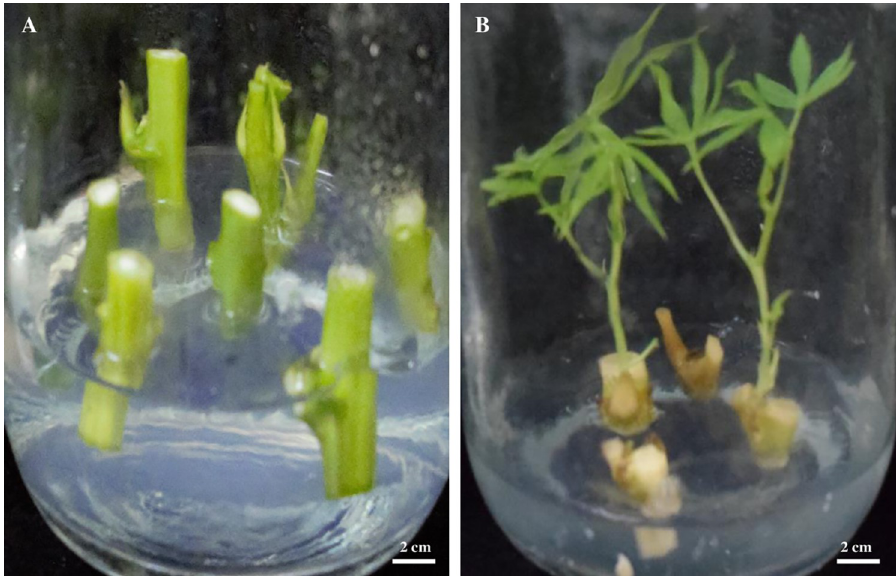
Fig 1. Cassava node propagation. A. cassava nodes with auxiliary buds cultured on MS medium. B. Node germinating on MS medium after 2 weeks